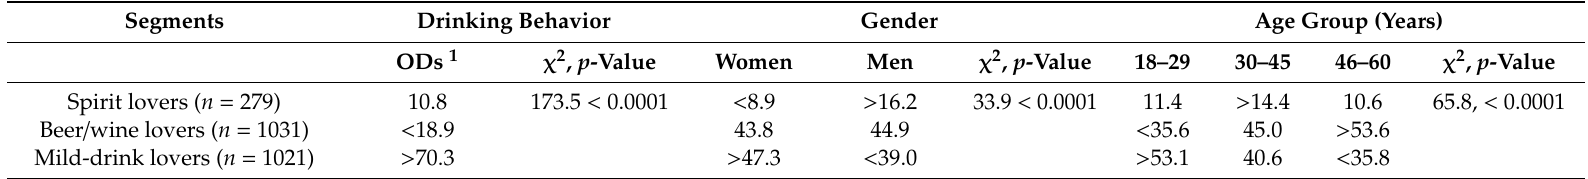
Table 3. Characterization of the three consumer segments (spirit lovers, beer / wine lovers, and mild-drink lovers) according to drinking behavior, gender, and age group. Values are reported in % with respect to the overall group ( n =